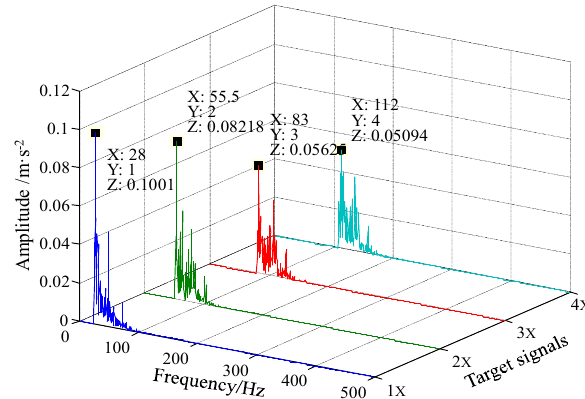
Figure 17. Detection results of the shaft-bending fault based on FERSR and frequency recovery.